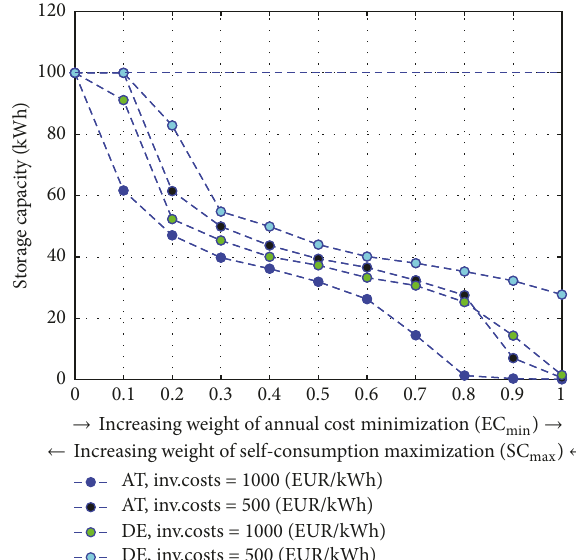
Figure 12: Comparison of optimally dimensioned storage capacity for different case studies. The maximal storage capacity is limited at 100 kWh, marked by the dashed blue line.